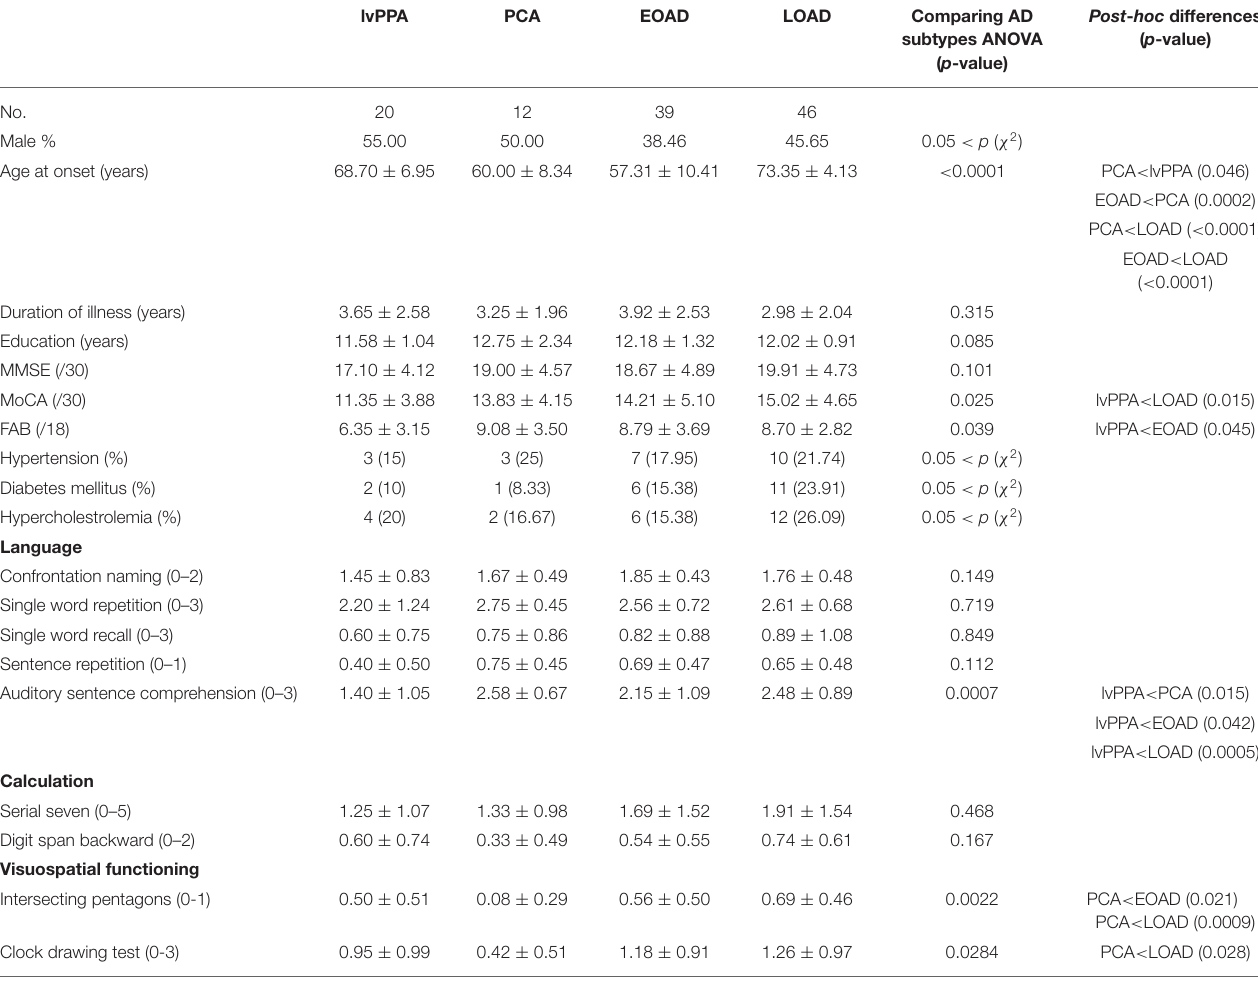
TABLE 2 | Demographics of the four subtypes of AD